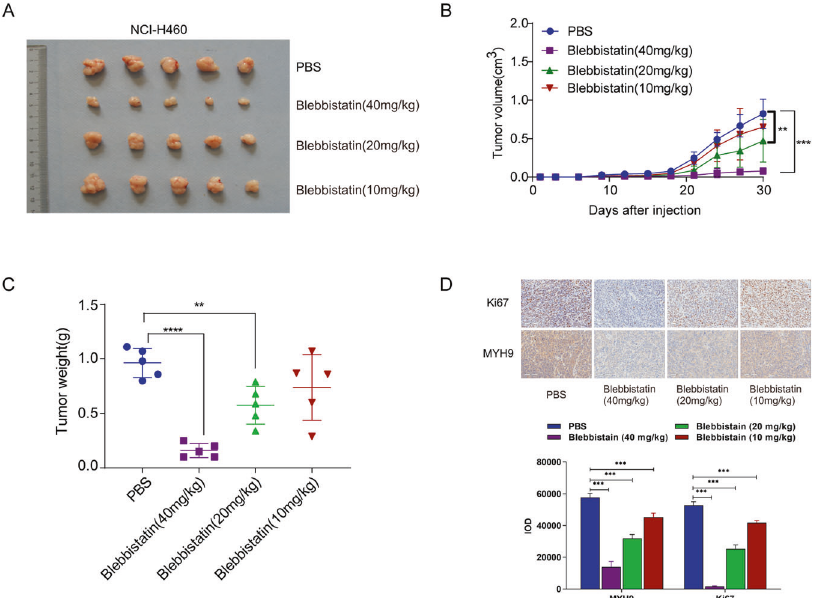
Fig. 4 Blebbistatin reduced tumorigenicity of MYH9 in vivo. A Xenografts were formed in the PBS group and high, middle, and low dose (40 mg/kg, 20 mg/kg, and 10 mg/kg) groups of blebbistatin. B Growth curve of xenografts in different dose groups of blebbistatin and PBS group ( n = 5; ** p < 0.01 and *** p < 0.001; Student ’ s t -test). C Tumor weights of xenografts in high, middle, and low dose groups of blebbistatin and PBS group ( n = 5; ** p < 0.01 and **** p < 0.0001; Student ’ s t -test). D Expression of MYH9 and Ki67 in xenograft tissues of different dose groups of blebbistatin and PBS groups (scale bar, 100 μ m; n =